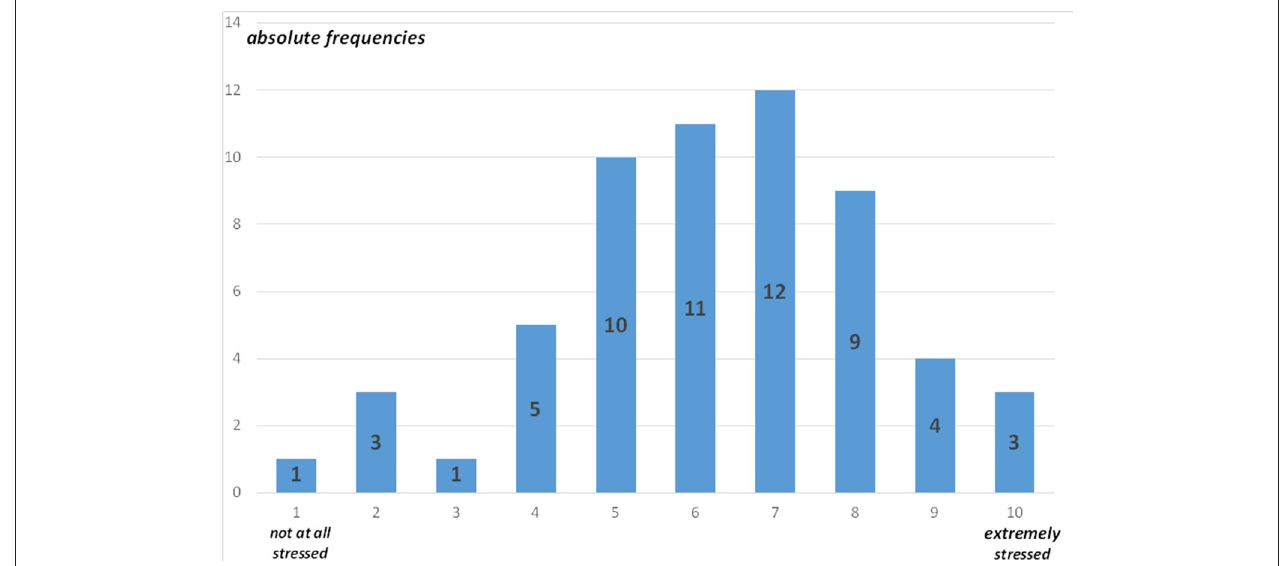
FIGURE 6 | Maximum burden of the COVID-19 pandemic on the psychosocial teams (59 entries, absolute frequencies).